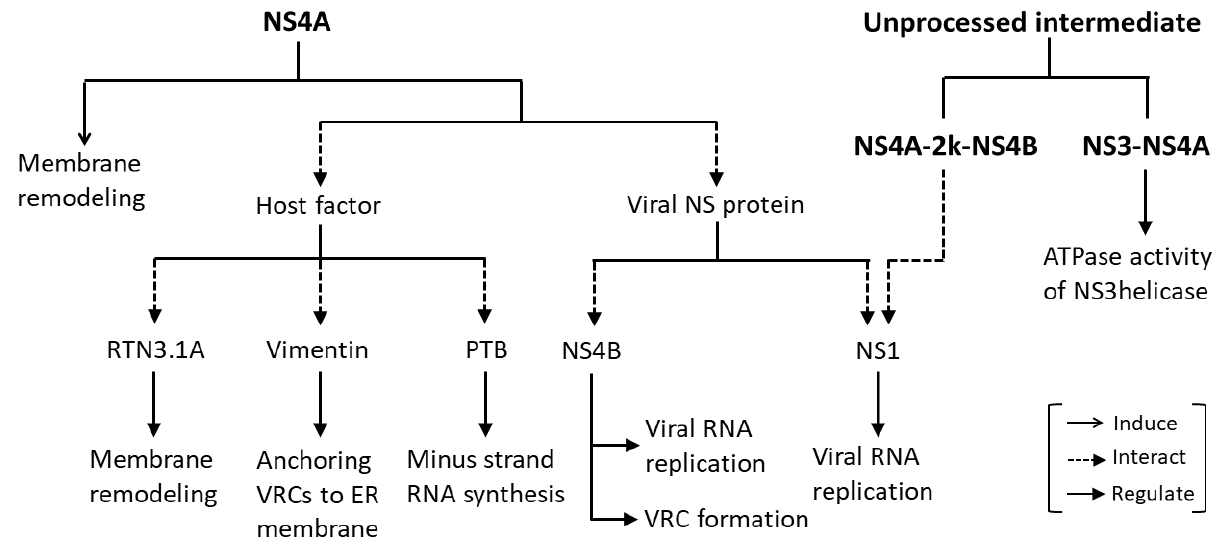
Figure 2. Roles of NS4As in flavivirus replication. NS4As induce membrane remodeling similar to that induced by flavivirus infection. NS4A and the unprocessed intermediates containing NS4A are essential components of viral replication complexes (VRCs), that interacts with host factors or other flavivirus NS proteins to promote efficient viral replication.